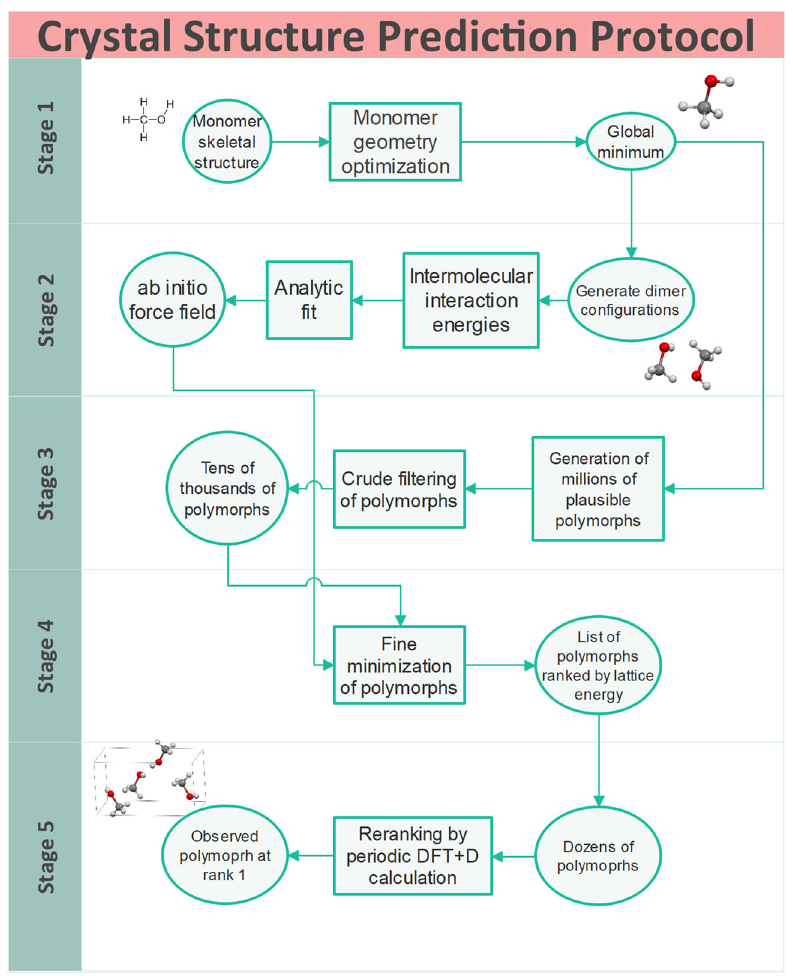
Fig. 1 Overview of aiFF-based CSP protocol. Stage 1: monomer energy minimization to fi nd the equilibrium geometry. Stage 2: ab initio calculations of dimer intermolecular interaction energies followed by fi tting an analytic form of aiFF to these data. Stage 3: generation of millions of plausible packing arrangements of polymorphs by sampling different space groups, orientations of monomers, and unit cell parameters, followed by a reduction of this set to tens of thousands of polymorphs using density criteria or crude lattice energy minimizations with simple FFs. Stage 4: fi ne minimization with aiFFs for all polymorphs in the reduced set. Stage 5: re fi nement of the ranking via pDFT + D calculations on a couple dozen top-ranked polymorphs from Stage